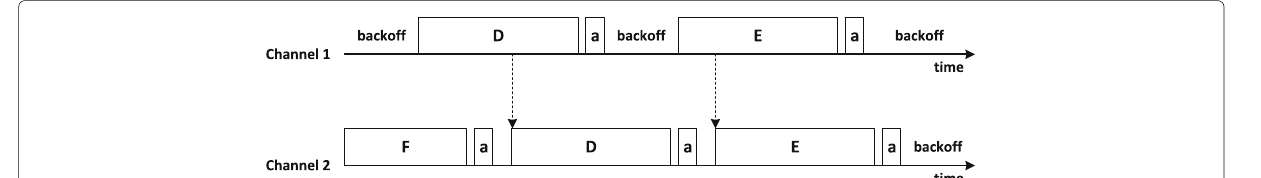
Fig. 4 The first approach for privileged access. When node D wins channel 1, it acquires privilege to access channel 2 without contention. The privilege is taken away when node D receives an ACK, or the ACK timer expires. In the figure, “a” stands for